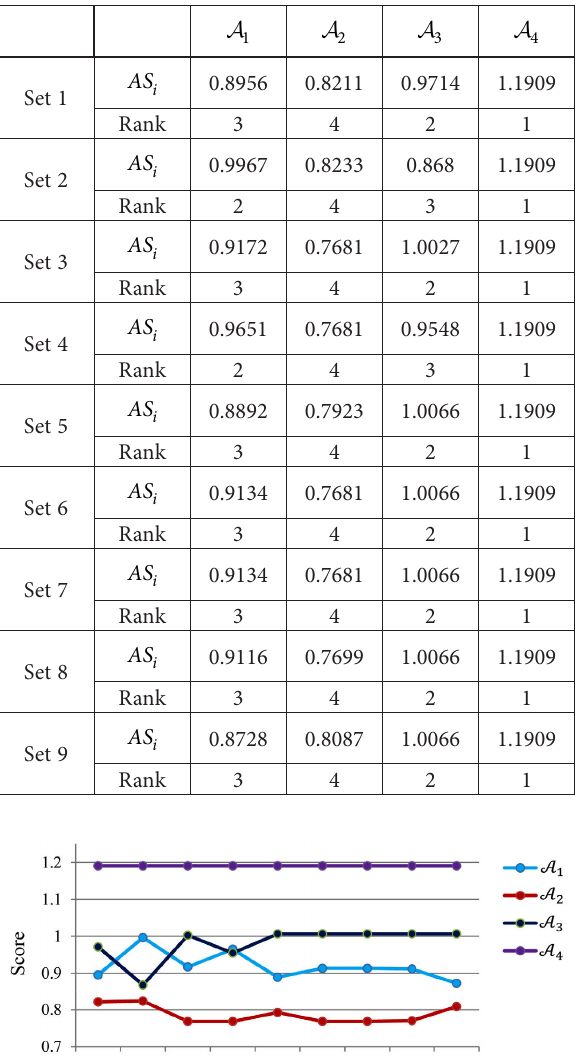
Table 10. The results of the sensitivity